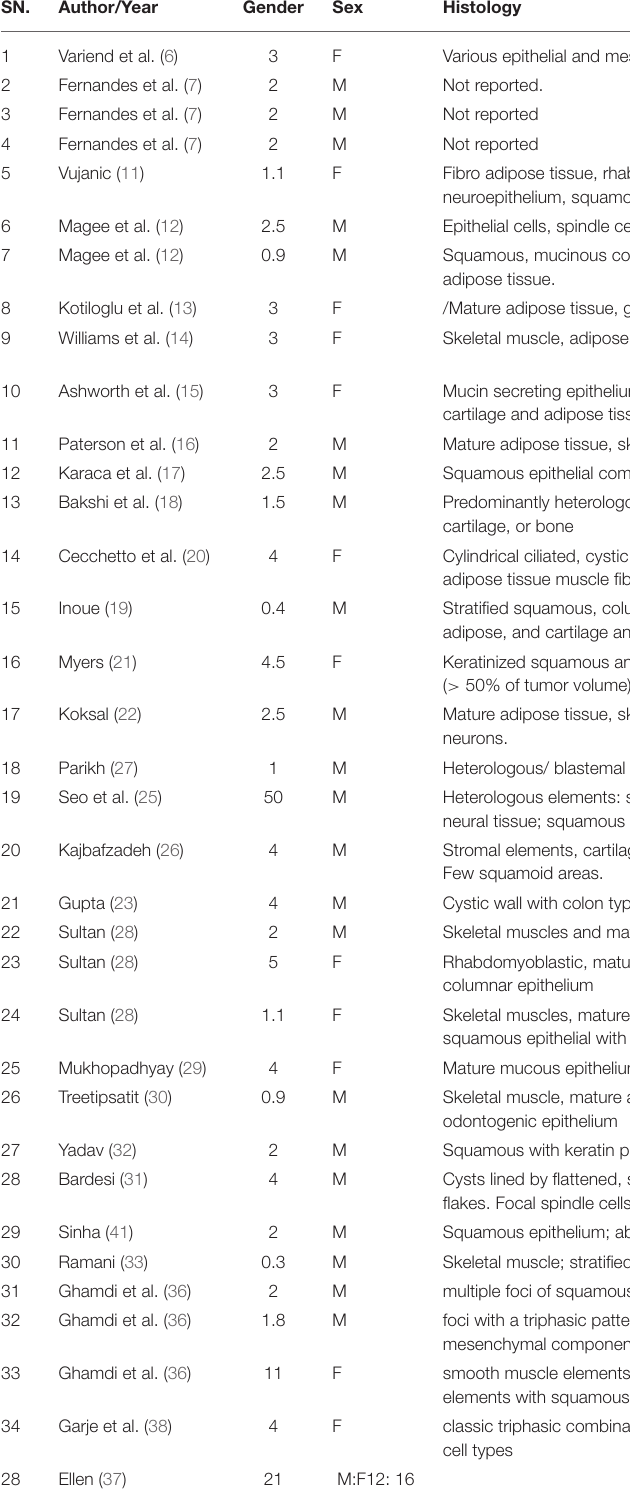
TABLE 4 | Published teratoid Wilms tumor cases.